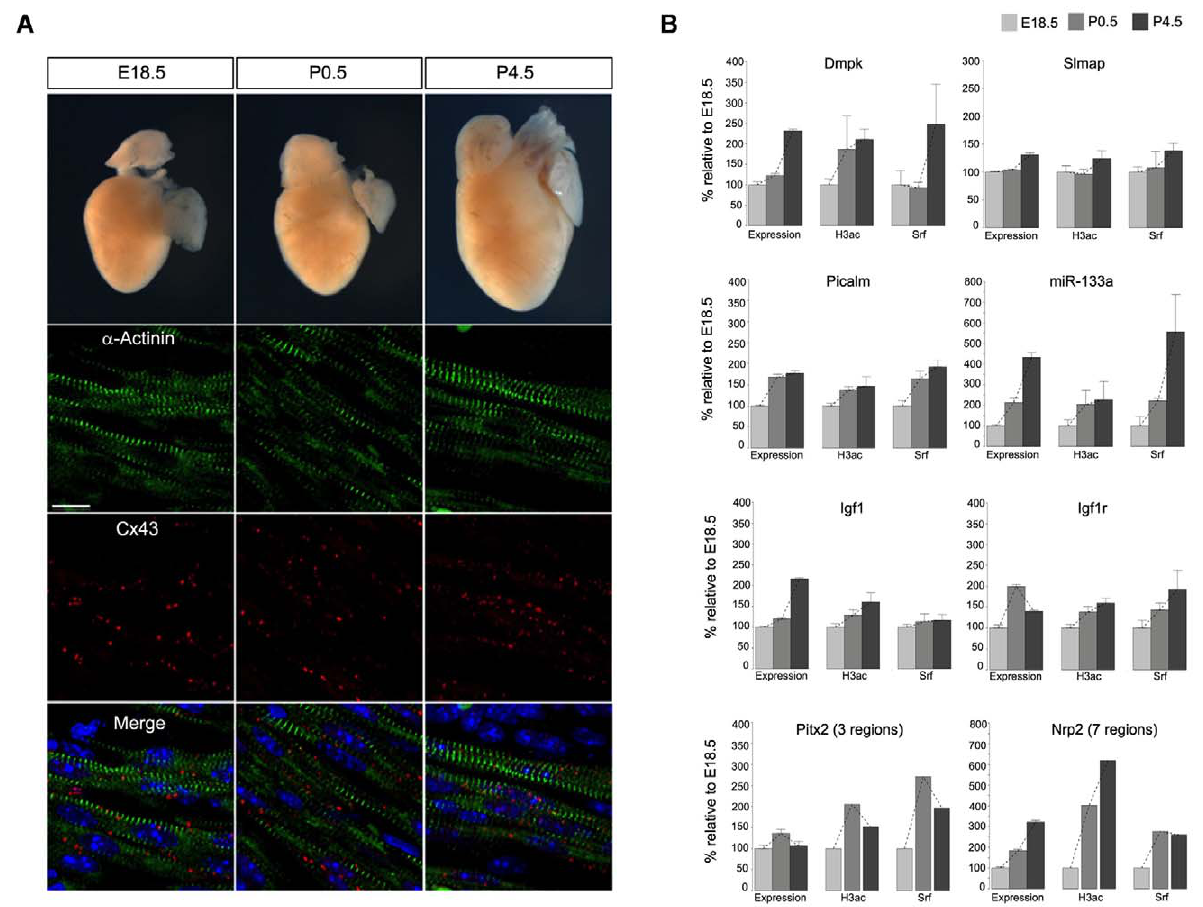
Figure 4. The impact of Srf and H3ac on gene expression in mouse hearts during cardiac maturation. (A) Cardiomyocyte maturation over three developmental stages around birth (E18.5, P0.5 and P4.5) with respect to alignment of myofibrils and cell-cell contacts. Paraffin sections of mouse hearts double labeled with antibodies against a -Actinin and Connexin 43 (Cx43) and examined under the confocal microscope. The a -Actinin stained myofibrils (in green, second panel) elongate and assemble throughout the maturation process while Cx43 (in red, third panel) forms distinct punctuations, which become larger and brighter. Nuclei are visualized in blue by DAPI counterstaining and merged pictures are shown in the lower panel. Scale bar 10 m m. (B) Confirmation of the dependency of expression levels on H3ac and Srf binding in mouse hearts using the time-series E18.5, P0.5 and P4.5. Expression levels as well as ChIP enrichment were analyzed by quantitative real-time PCR and normalized to Hprt and Input, respectively. Shown changes of expression levels as well as Srf and H3ac binding over time are in general significant. Values are given in percentages relative to E18.5. For Pitx2 and Nrp2 the additive effect of several measured genomic regions is shown.